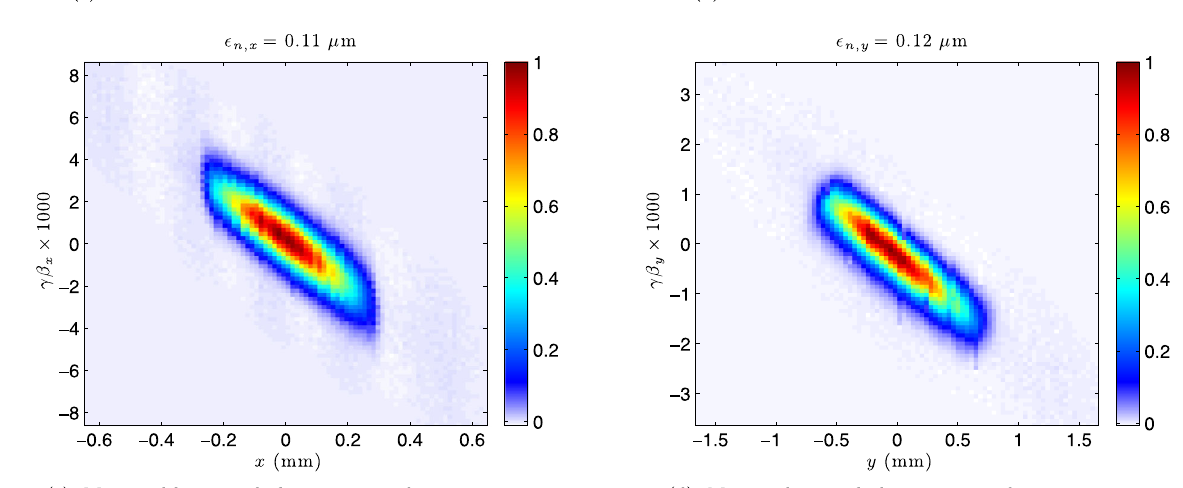
FIG. 10. Projected emittance measurement at the cathode using a solenoid scan (a) and (b), and corresponding measurements in the merger section (c) and (d). The colormap and normalization in (c) and (d) is used for all subsequent phase-space plots in this work. The estimated error for these emittance values was (cid:1) 0 : 01 (cid:1) m